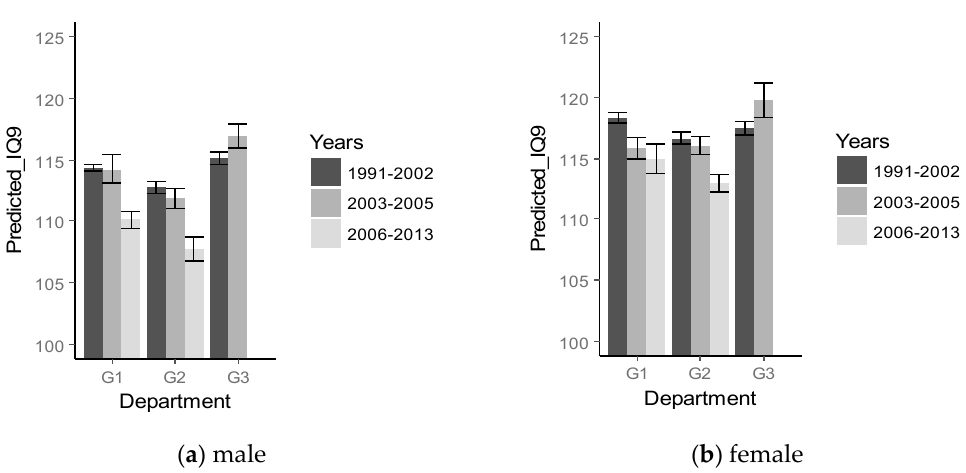
Figure 7. Dynamics of short-term memory (subtest IQ9) among male ( a ) and female ( b ).